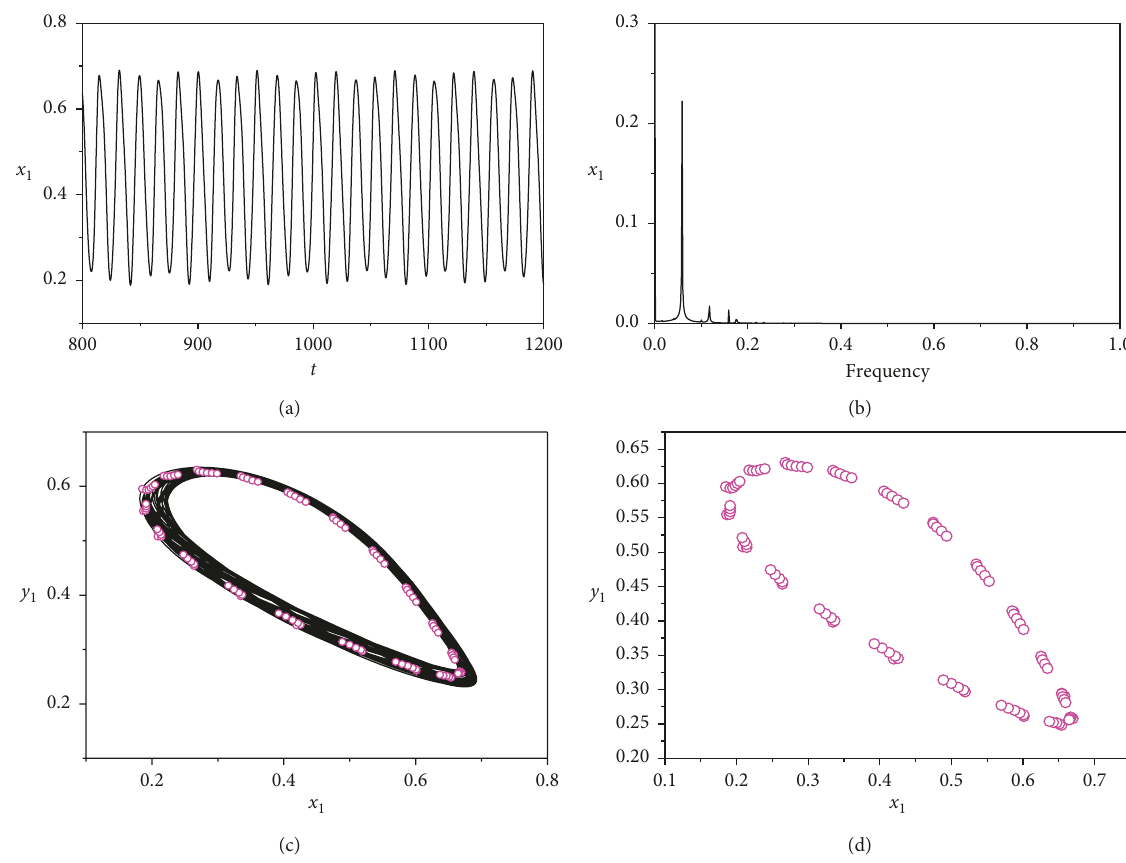
Figure 9: ω � 3.58: (a) displacement response; (b) frequency spectrum; (c) rotor orbit; (d) Poincar´e maps.